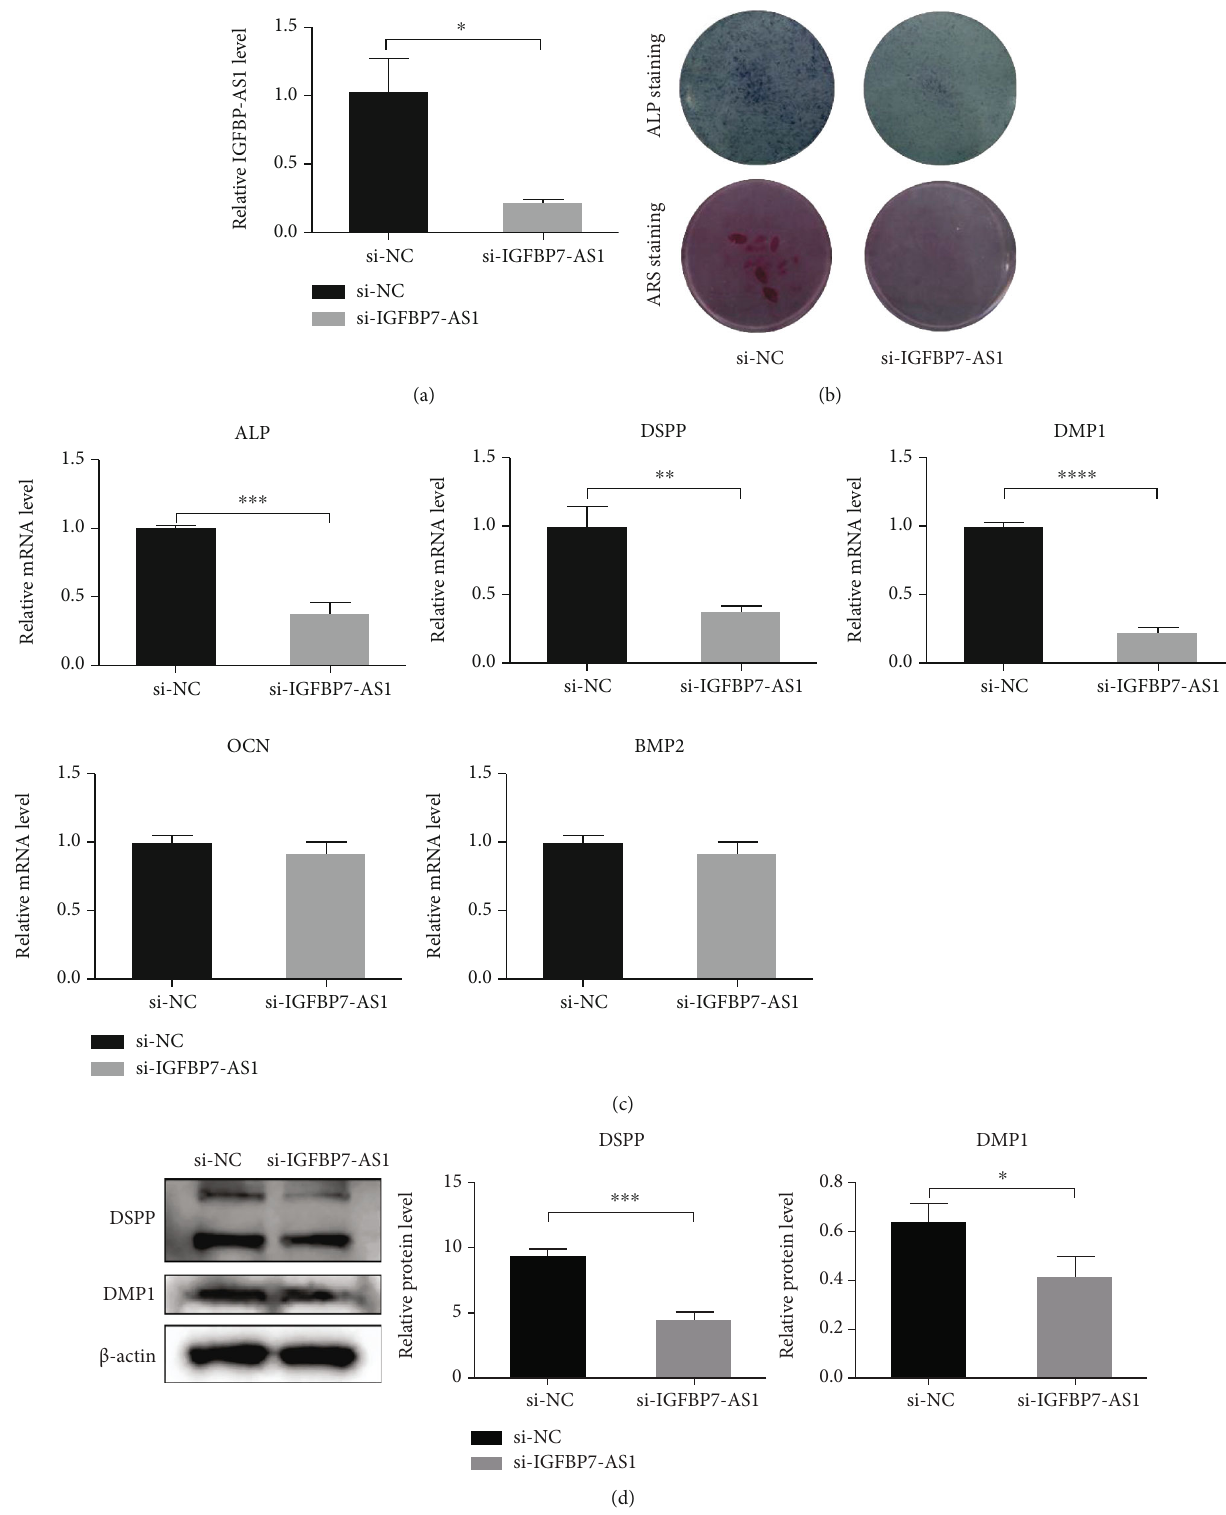
Figure 3: IGFBP7-AS1 knockdown suppresses the odontogenic di ff erentiation of SHED. (a) qRT-PCR detected lncRNA IGFBP7-AS1 levels in the si-NC and si-IGFBP7-AS1 groups. (b) Images of ALP staining of SHED on day 7 after odontogenic di ff erentiation and ARS staining of SHED on day 14 after odontogenic di ff erentiation in the si-NC and si-IGFBP7-AS1 groups. (c) qRT-PCR detected osteo/odontogenic di ff erentiation-related markers: ALP, DSPP, DMP1, OCN, and BMP2 in the si-NC and si-IGFBP7-AS1 groups. (d) Western blot detected odontogenic di ff erentiation-speci fi c markers: DSPP and DMP1 in the si-NC and si-IGFBP7-AS1 groups. Data were expressed as the mean ± standard deviation (SD) of three experiments per group, ∗ p < 0 : 05 , ∗∗ p < 0 : 01 , ∗∗∗ p < 0 : 001 , and ∗∗∗∗ p < 0 : 0001